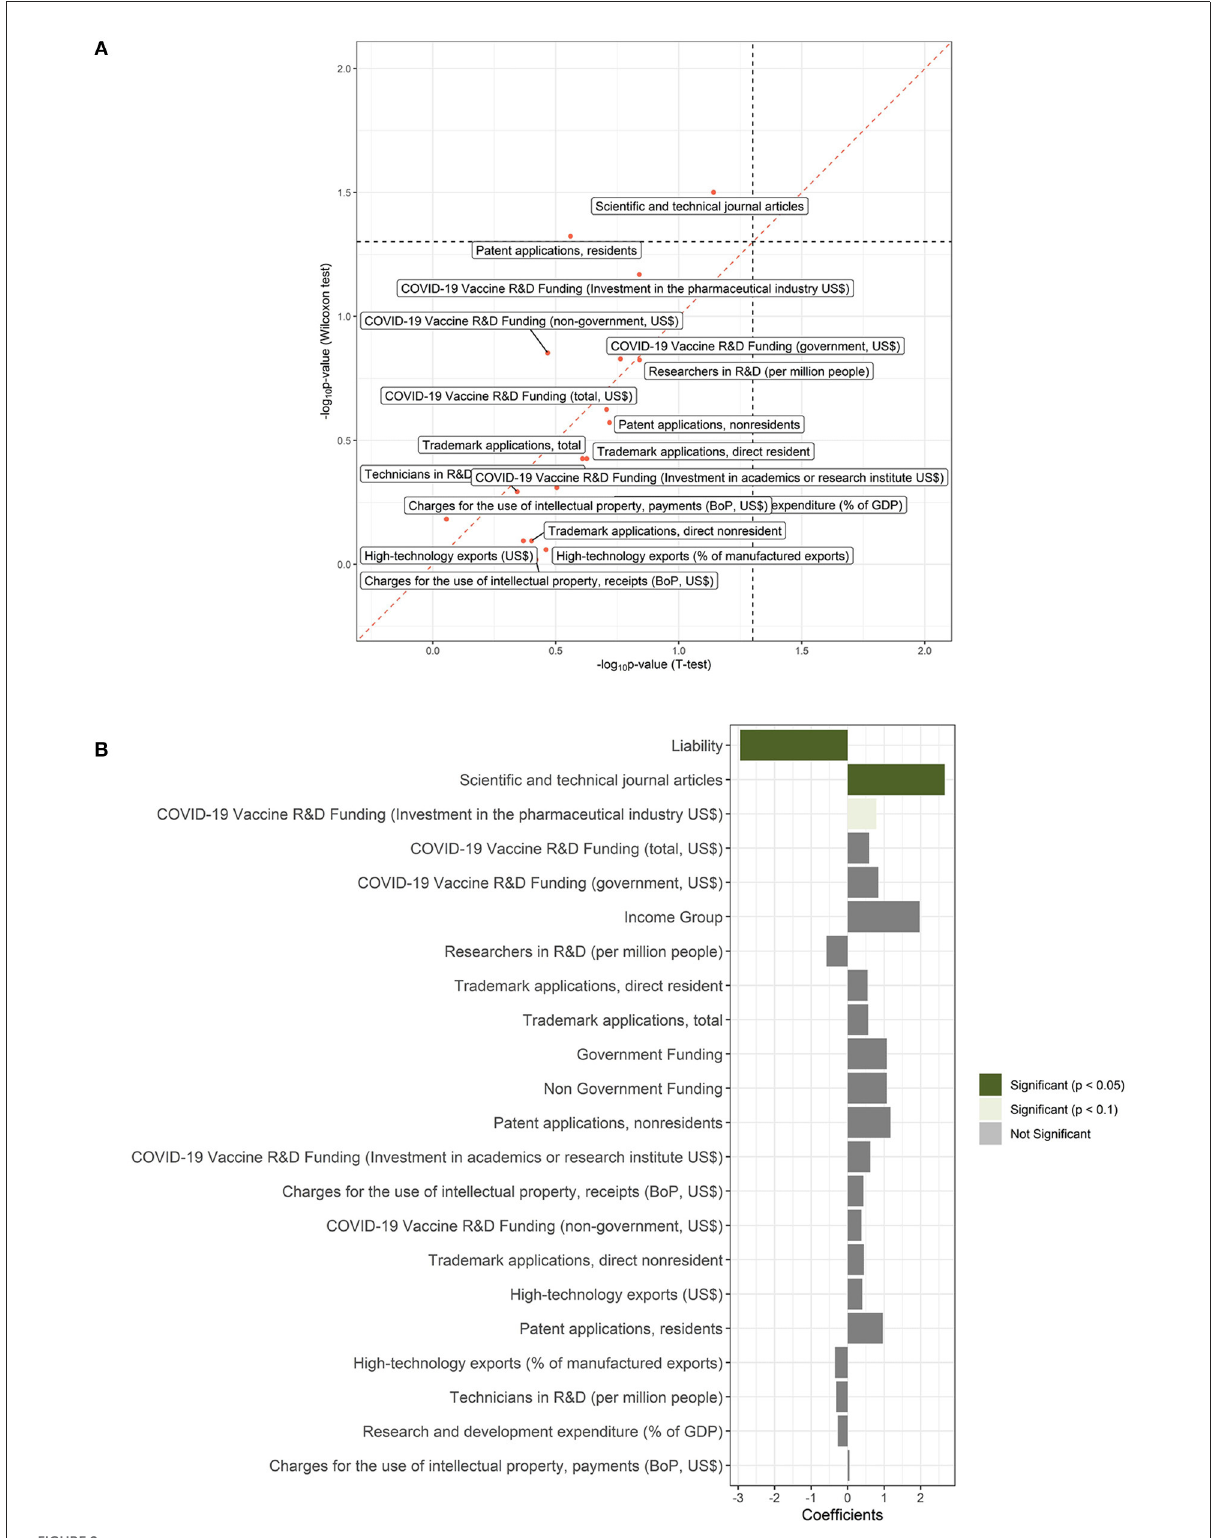
FIGURE2 Results of association analysis. (A) -log10 ( P- value) values of the continuous variables of the t -test vs. the Wilcoxon test. (B) Results from the simple logistic regression. The bars show the effect sizes and the colors show the level of significance by P -values. Significance means P < 0.05, Evidence means P < 0.1 and not-significance means P >